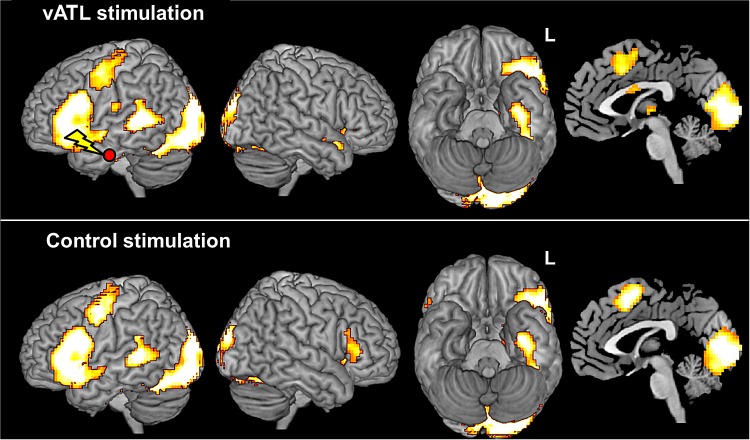
Brain activation maps of the synonym–number judgment contrast for the vATL stimulation (top) and the control stimulation (bottom). Activations displayed in the red/yellow color scale are survived at the cluster level, PFWE-corrected< 0.05 with at least 100 voxels.